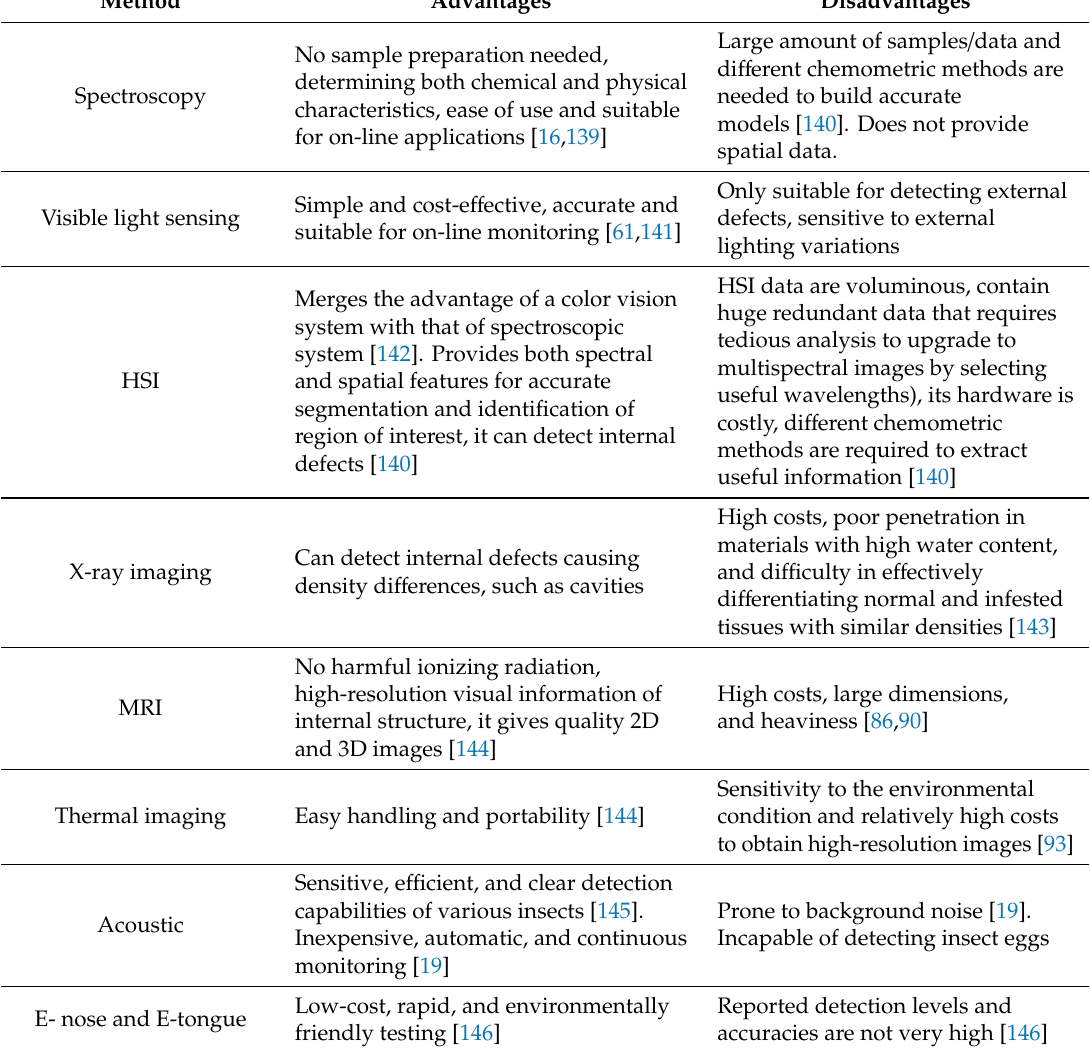
Table 4. Merits and demerits of the di ff erent nondestructive